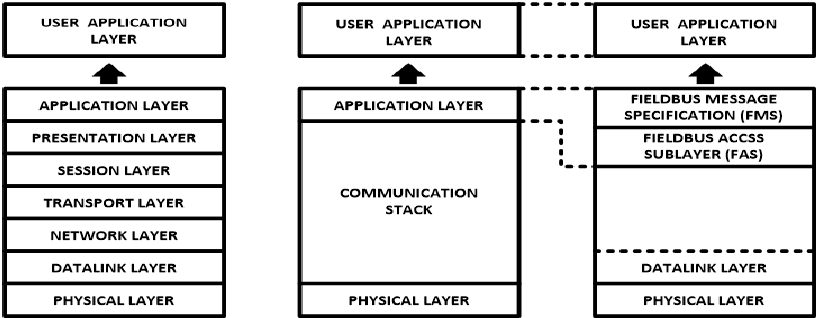
Figure 2. Foundation Fieldbus OSI (open systems interconnection) model.